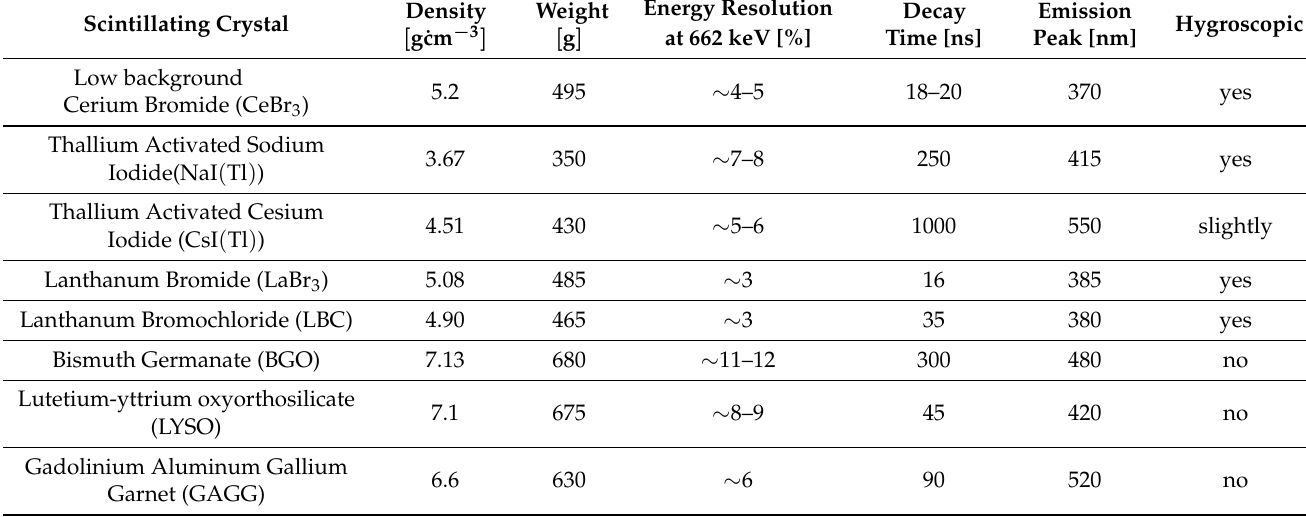
Table 2. Physical characteristics of scintillating crystals considered in the paper as building block of the payload target. In red, the crystals affected by unavoidable intrinsic radioactivity (parameter values can change at the level of few percent depending on the manufacturing